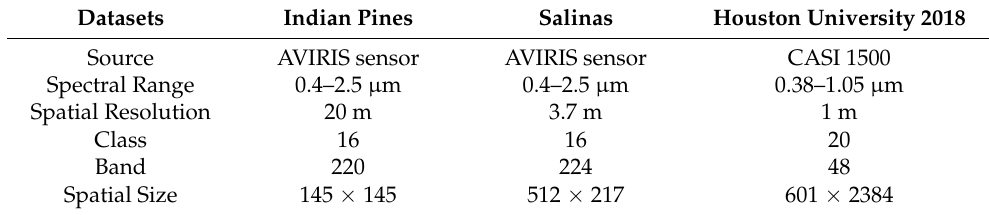
Table 1. Details of the three experimental